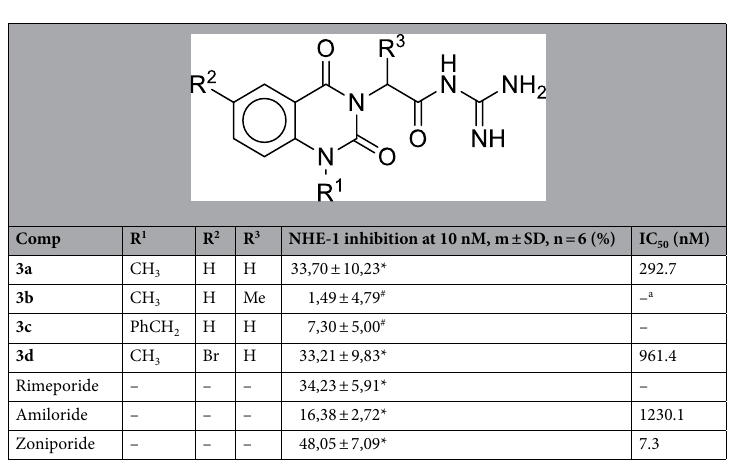
Table 1. NHE-1 inhibition by novel quinazoline-2,4(1 H ,3 H )-dione derivatives with acyclic guanidine moiety. Statistical significance: * p < 0,05 vs. negative control; # p < 0,05 vs. Zoniporide (1-way ANOVA). a Not